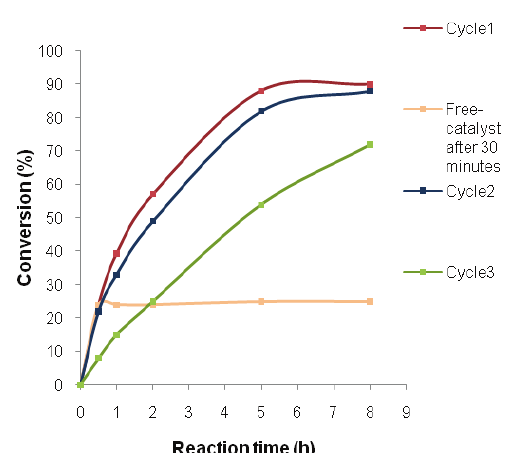
Figure 10. Kinetic curves for three recovery/reutilization cycles